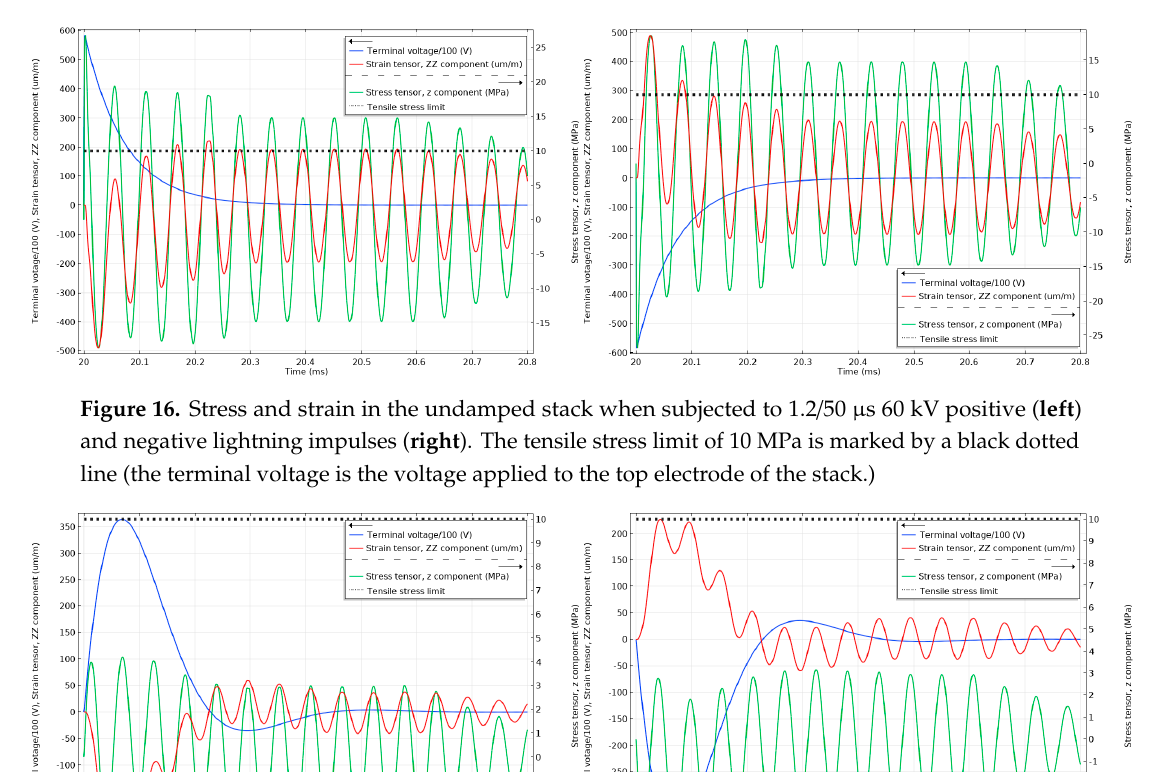
Figure 15. Stress and strain in the undamped stack when subjected to attenuated 75 kV positive ( left ) and negative ( right ) lightning impulses. The tensile stress limit of 10 MPa is marked by a black dotted line (the terminal voltage is the voltage applied to the top electrode of the stack.).